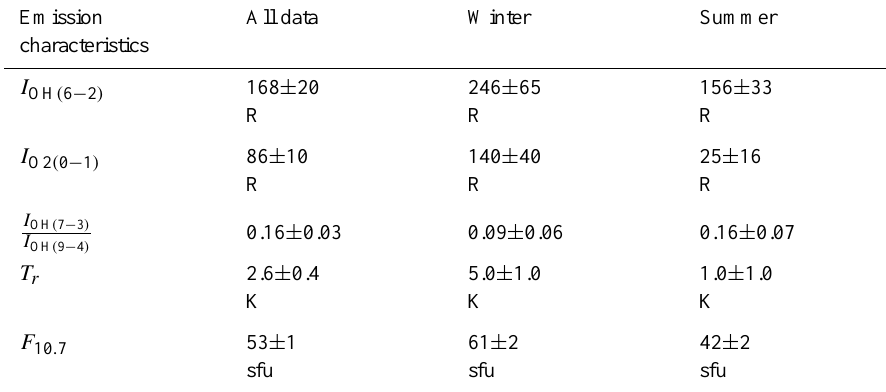
Table 3. Amplitude of the 11-year variation.